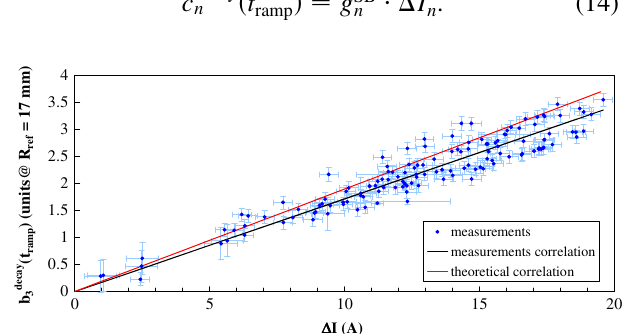
FIG. 9. (Color) Scatter plot of the sextupole fit parameters (cid:1) t (cid:2) (units @ R that correspond to 17 mm ) and (cid:1) I n ramp ref sets of different powering cycles in the LHC dipoles tested and analyzed to date. The data has been fitted with a linear regression and is compared to the theoretical prediction presented in